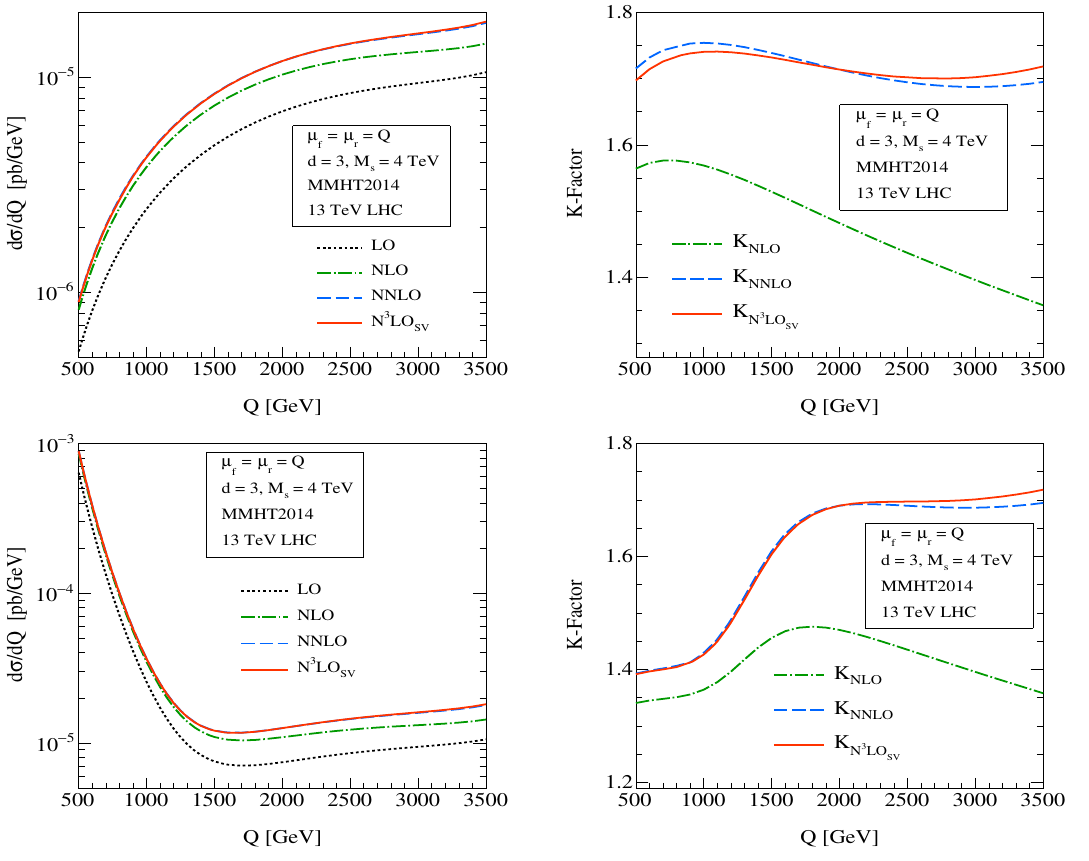
Figure 1 . Invariant mass distribution of di-lepton pair at LHC center of mass energy 13 TeV for ADD model (gravity only) and signal (SM + gravity) (left panel from top to bottom) and their corresponding K factors on the right panel. (from top to bottom).